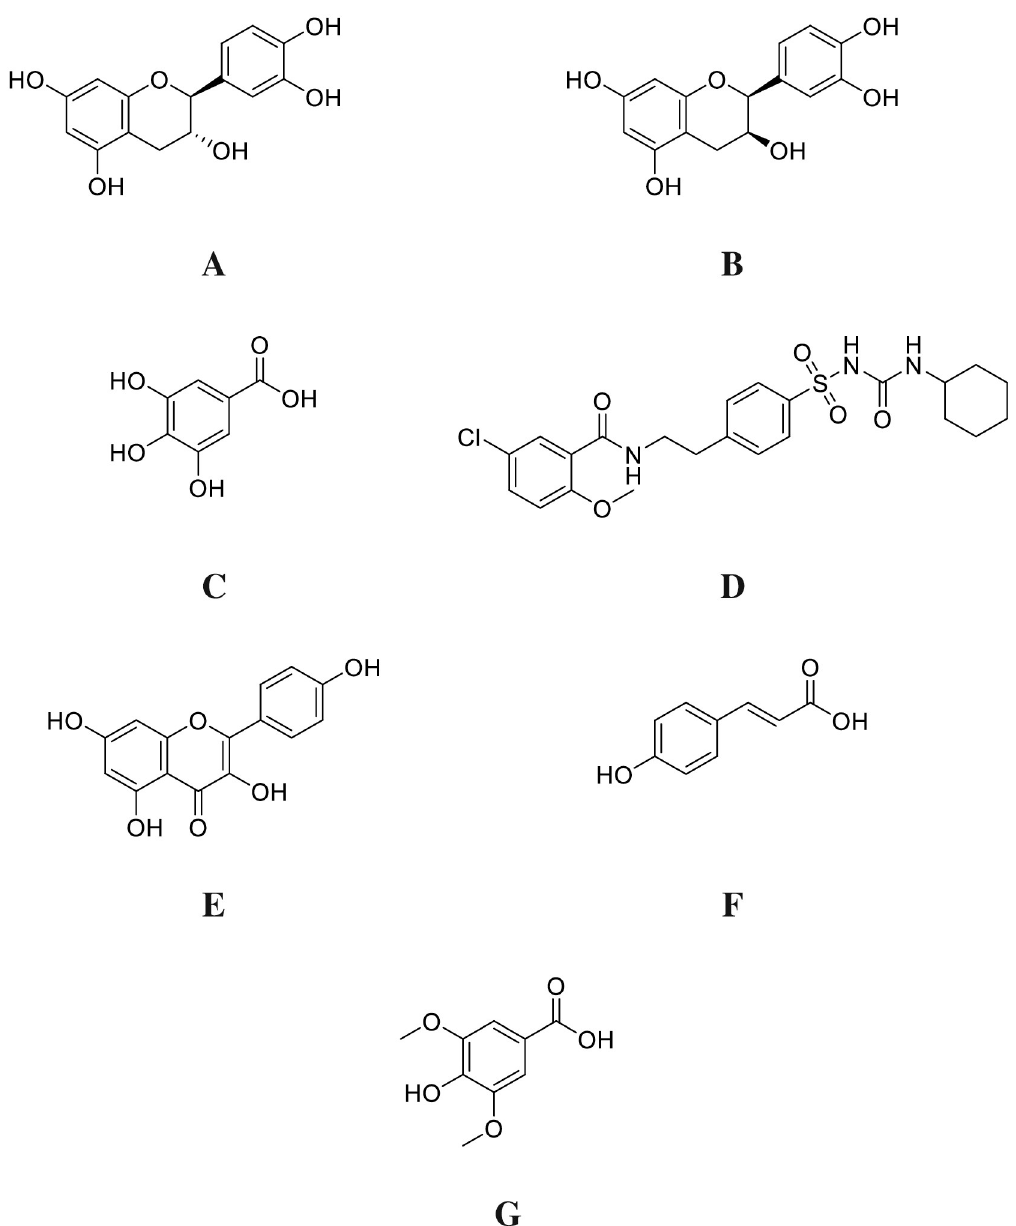
Fig 1. The D2- structures of A: Catechin B : Epicatechin C : Gallic Acid D : Glibenclamide E : kaempferol F : P-Coumaric Acid and G : Syringic acid docked studied compounds. https://doi.org/10.6084/m9.figshare.21828843.v1.